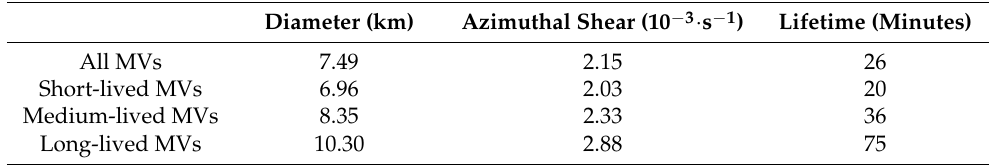
Figure 4. Distributions of the ( a ) diameter (km) and ( b ) intensity (10 − 3 · s − 1 ) of the MVs in Guangdong from April to June during 2017–2019. Table 2. Average diameter, azimuthal shear intensity and lifetime of the MVs in Guangdong from April to June during 2017–2019.